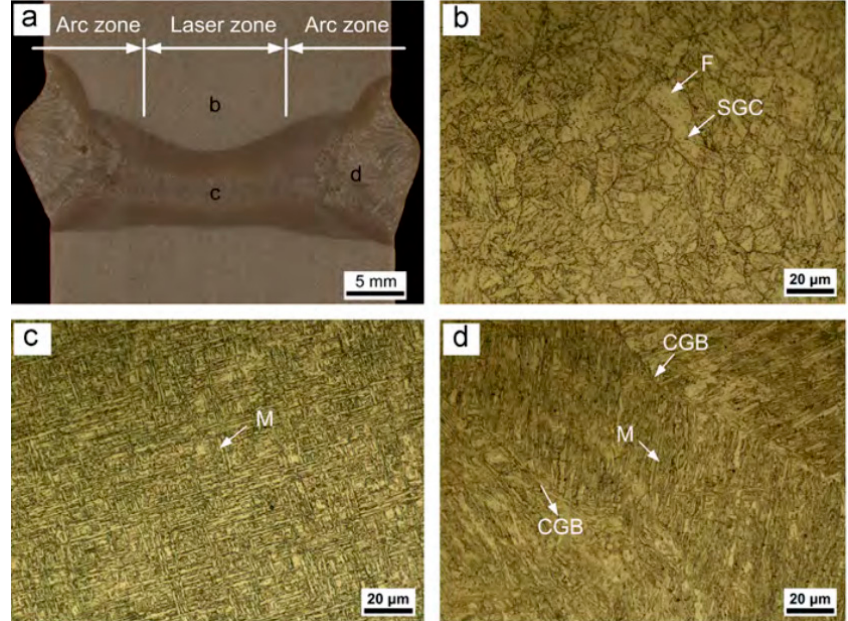
Figure 15. Macrograph of double-sided hybrid joint ( a ), microstructure of base material ( b ), laser zone ( c ) and arc zone ( d ), where F corresponds to polygonal ferrites, SGC to small granular carbides, CGB to columnar grain boundary and M to martensite (reproduced from [82] with permission, Elsevier, 2013).